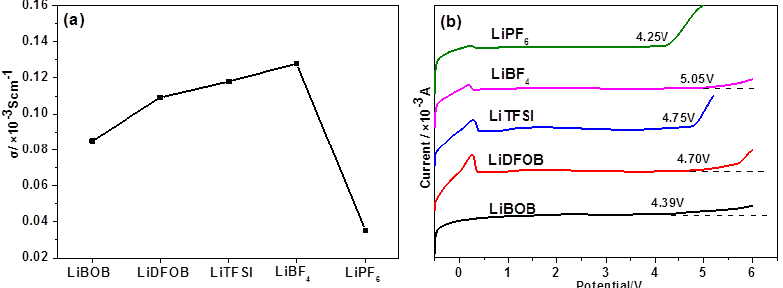
Figure 2. ( a ) Ionic conductivity at 30 °C and ( b ) room-temperature electrochemical windows of different lithium salt-EOEOEA 50% GPEs.